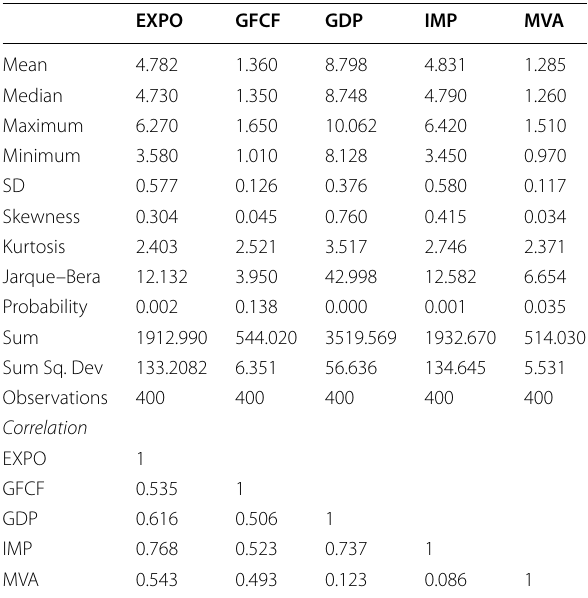
Table 3 Descriptive statistics and correlation. Source : Computed from secondary